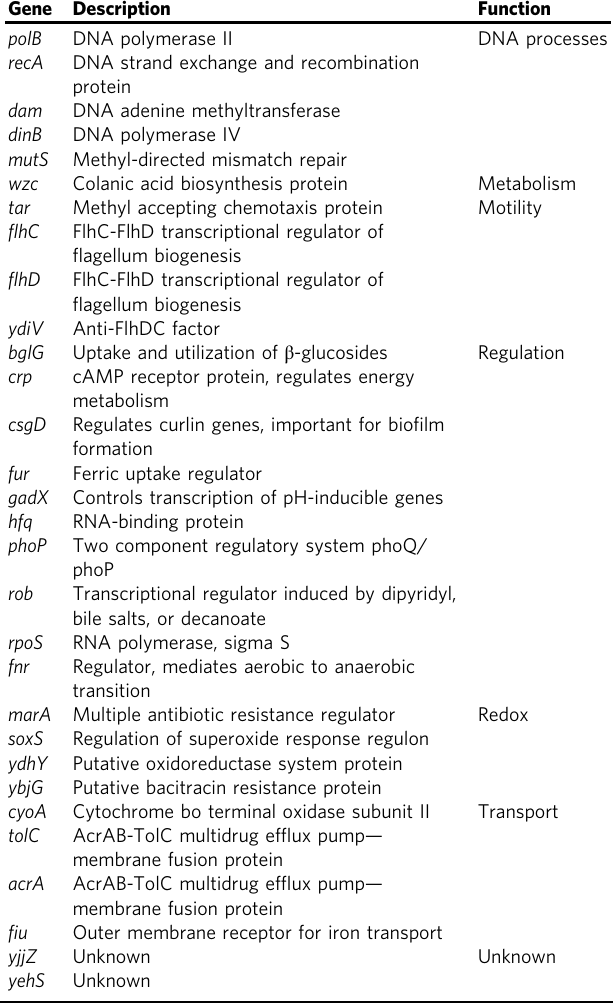
Table 1 The 30 genes in Escherichia coli BW25113 investigated in this